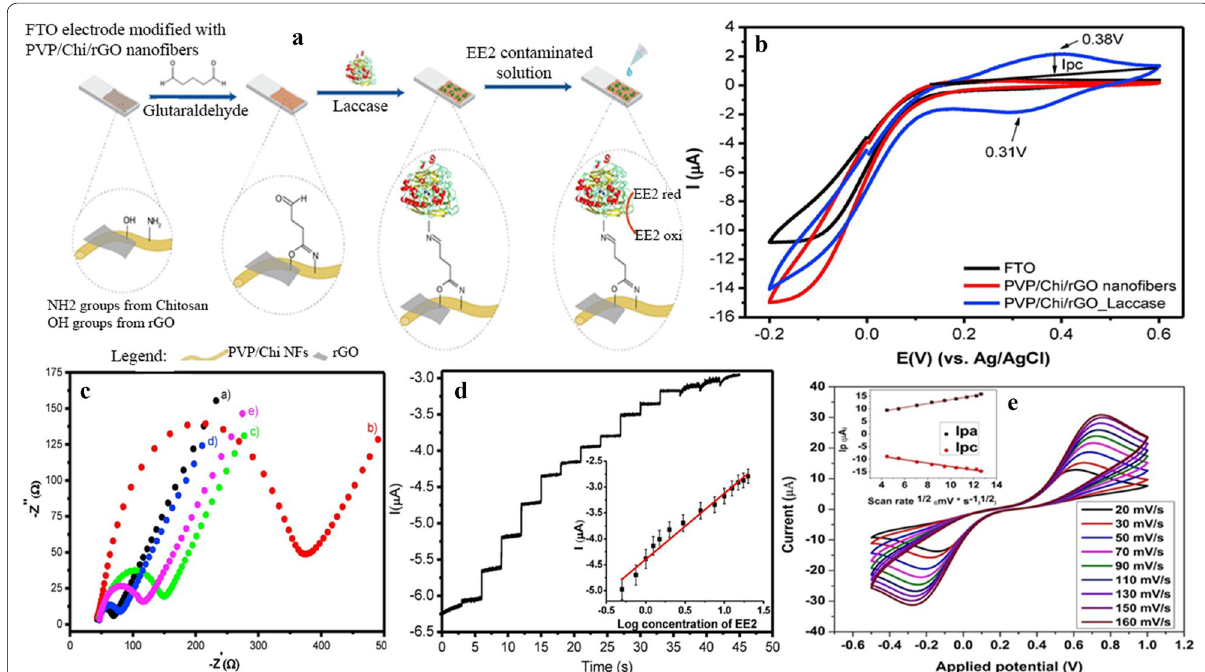
Fig. 6 a Schematic representation of the fabrication of EE2 electrochemical biosensor. b Cyclic voltammetry measurements using a PBS buffer solution (pH 7.4) and scan rate of 100 mV s − 1 for PTO, PVP/Chi/rGO ES NFs and PVP/Chi/rGO ES NFs coated with Laccase enzyme. c Nyquist plots of EIS for (a) FTO, (b) PVP nanofibers, (c) PVP/Chi nanofibers, (d) PVP/Chi/rGO nanofibers and (e) PVP/Chi/rGO nanofibers coated with Laccase in a 5 mmol L − 1 [ Fe ( CN ) 6 ] 3 − / 4 − solution with 0.1 mol L − 1 KCl. d Amperometric response upon successive additions of EE2 ethanol solution recorded at PVP/Chi/rGO_Laccase coated electrode in a phosphate buffer solution pH 7.0 in concentrations ranging from 0.25 to 20 pmol L − 1 at a fixed potential of 0.3 V. The inset shows the calibration curve with the respective linear fit. a – d reproduced from with permission from [162] Copyright − 2018 Elsevier. (E) Schematic of cyclic voltammetry shown the electrochemical behaviour of BSA/BH/PNF/GCE in presence of [Fe(CN) 6 ] 3 − /4 − at different scan rates (20–160 mV/s). It can be revealed that, the increase in the peak to peak voltage difference is also an indication of the progressive immobilization and the anodic peak shifts towards the higher potential value whereas the cathodic peaks shift towards lower potential value with the increase in the scan rate Reproduced with permission from [129] Copyright 2019